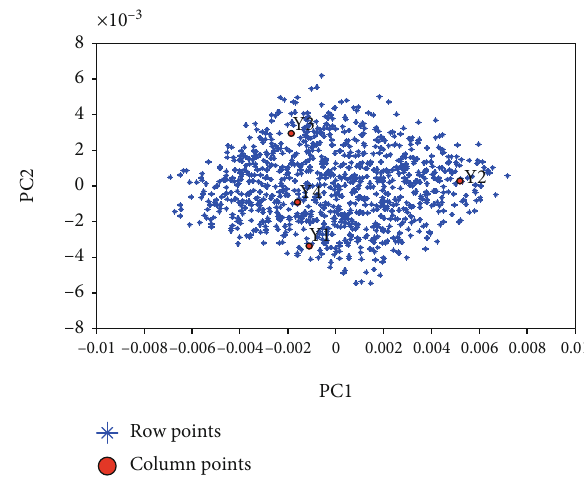
Figure 11: Results from a large number of samples for the data matrix of the turbocharging